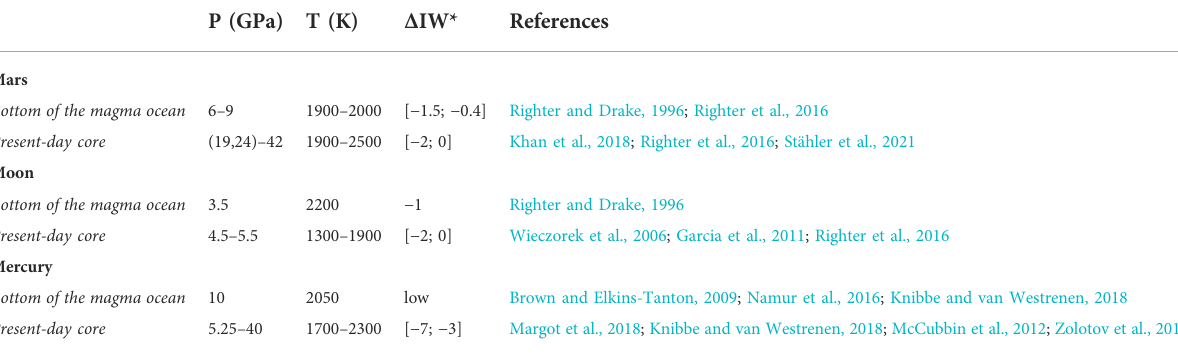
TABLE 1 Pressure, temperature, and redox conditions considered for the bottom of the magma ocean and presented-day core of Mars, the Moon, and